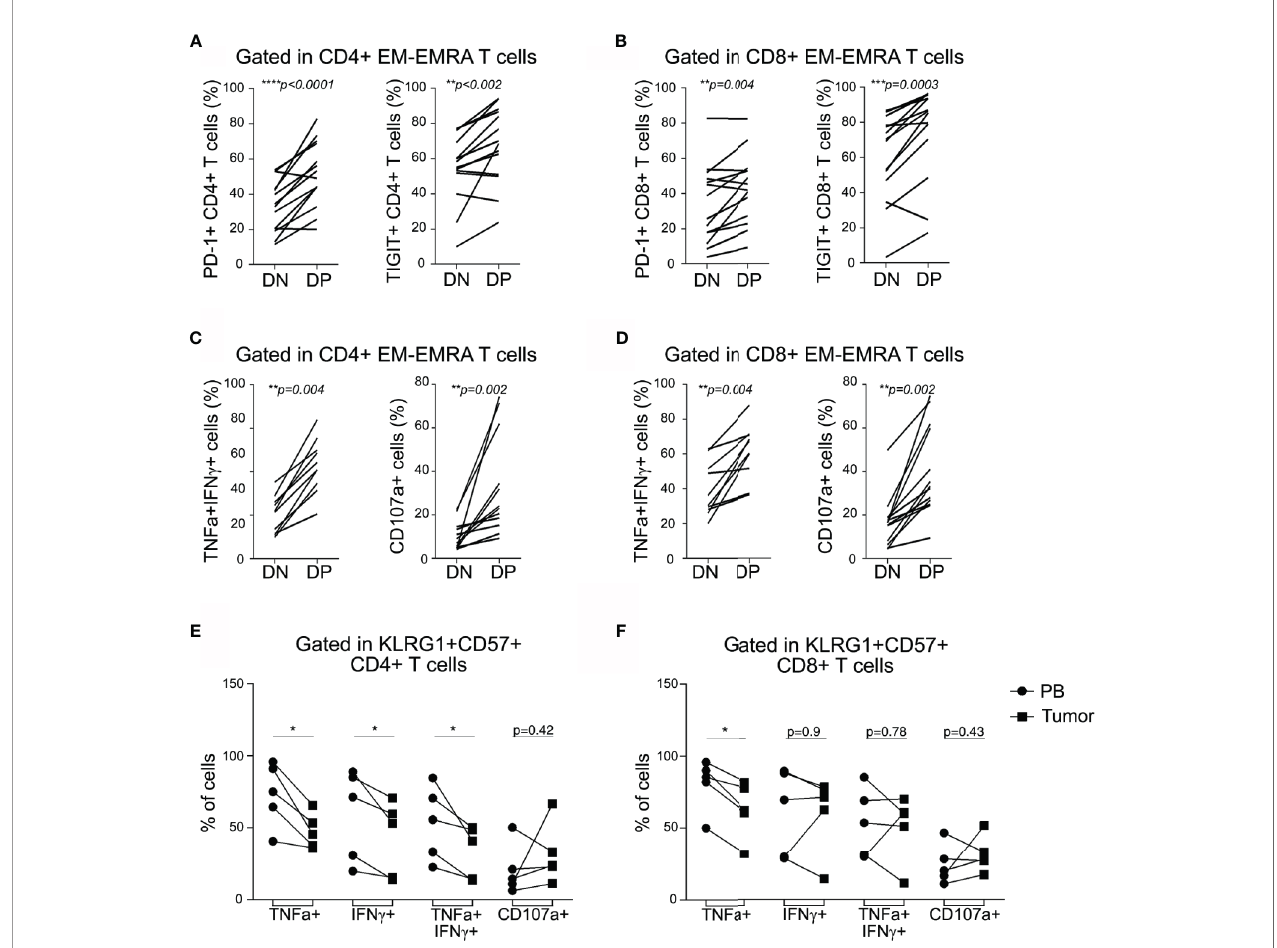
FIGURE 4 | Tumor-in fi ltrating CD4 + and CD8 + T cells express inhibitory receptors and are highly polyfunctional cells. (A, B) Frequency of tumor-in fi ltrating CD4 + (A) and CD8 + (B) T cells expressing PD-1 or TIGIT within EM/EMRA populations and within DN and DP subsets as indicated in graphs. Each line represents a sample analyzed. (C, D) Frequency of tumor-in fi ltrating CD4 + (C) and CD8 + (D) T cells co-expressing TNF and IFN g or expressing CD107a within EM/EMRA populations and within DN and DP subsets as indicated in graphs. Each line represents a sample analyzed. Paired t -tests were used to compare DN and DP subsets ( p are indicated in each graph). (E, F) Frequency of cytokine- or CD107a-expressing senescent CD4 + (E) and CD8 + (F) T cells within EM/EMRA populations in peripheral blood (PB, circles) vs tumor (squares). Each line represents a paired PB – tumor from the same patient. Paired t -tests were used to compare both tissues (PB vs. T: * p <